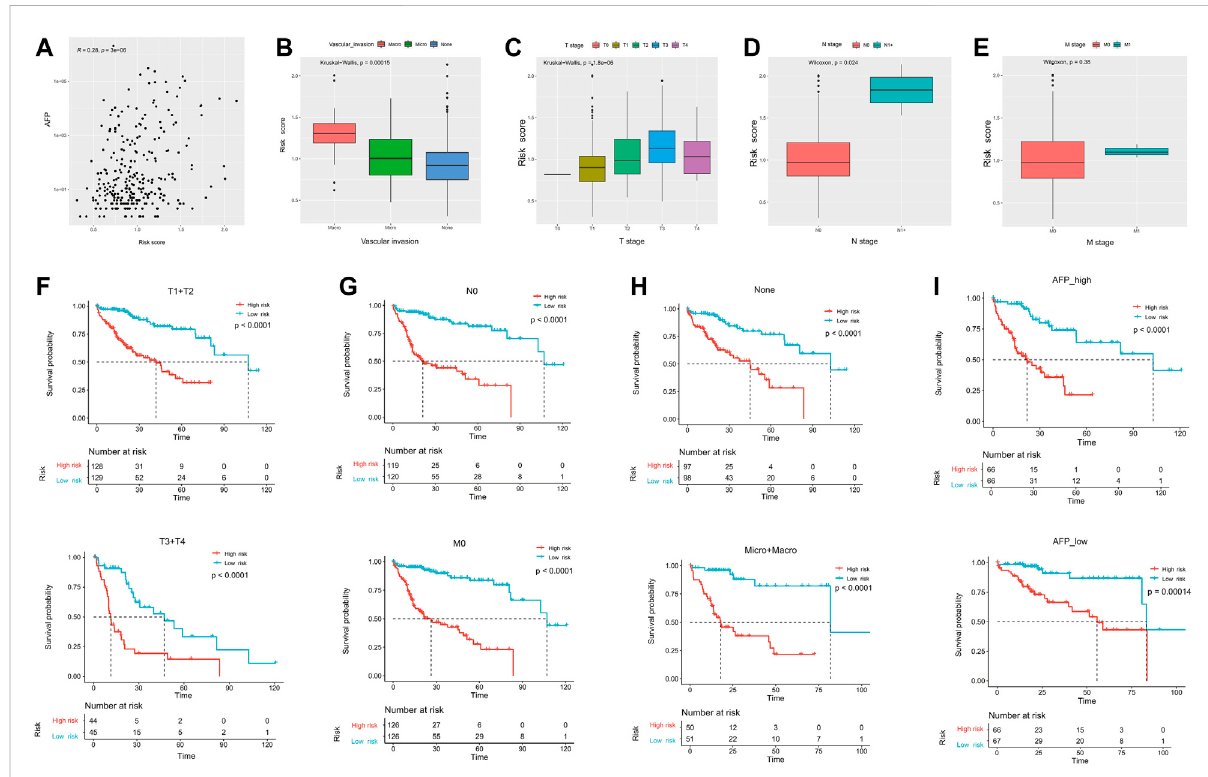
FIGURE 3 Correlation of ECM-related prognostic models with clinicopathological parameters. The correlation of the risk score and (A) AFP, (B) vascular invasion, (C) primarytumorstage, (D) regionallymphnodesstage,and (E) distantmetastasisstage. (F – I) Amongthedifferentstrati fi edsubgroups,the high-risk group had a poor prognosis. AFP, α